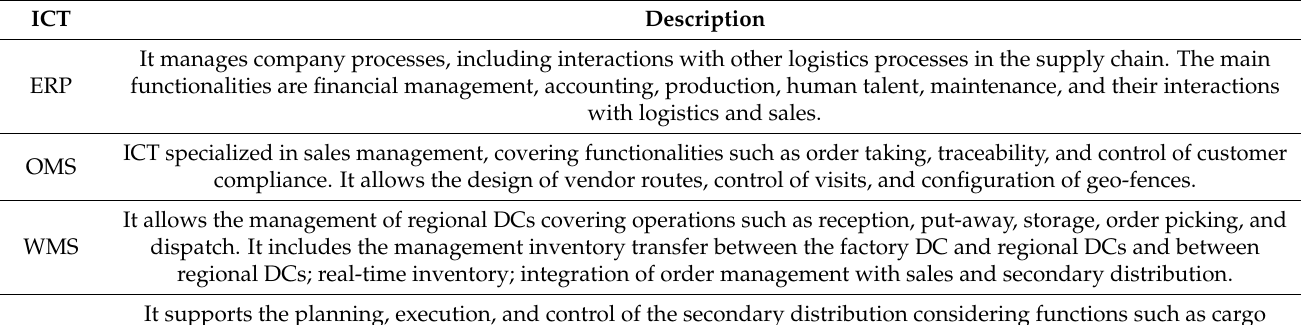
Figure 2. Information and technology architecture for the secondary distribution. Table 12. ICT in the business architecture of the secondary distribution.